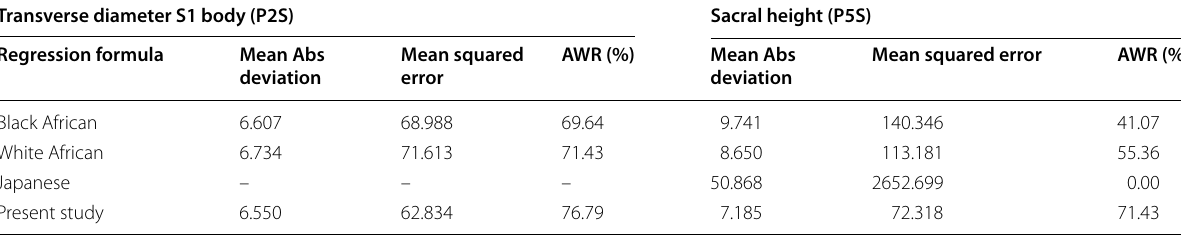
Unit in centimetre (cm) AWR represents the accuracy percentage of estimated stature within SEE range compared to actual stature